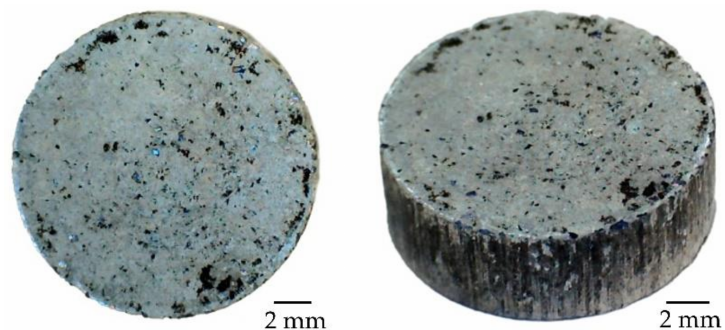
Figure 4. Al foam with 70 vol.% of design porosity in brown